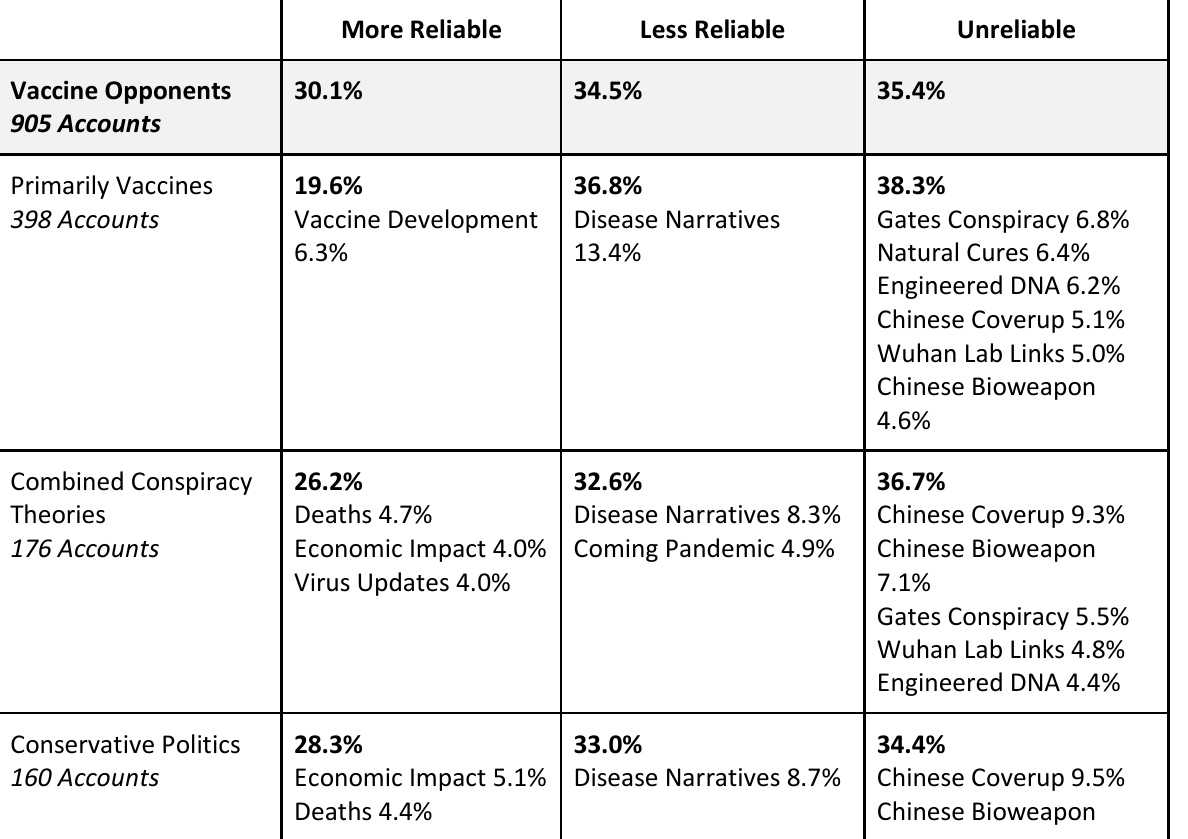
Table 4. Breakdown of topics for top 3 subgroups (featuring topics